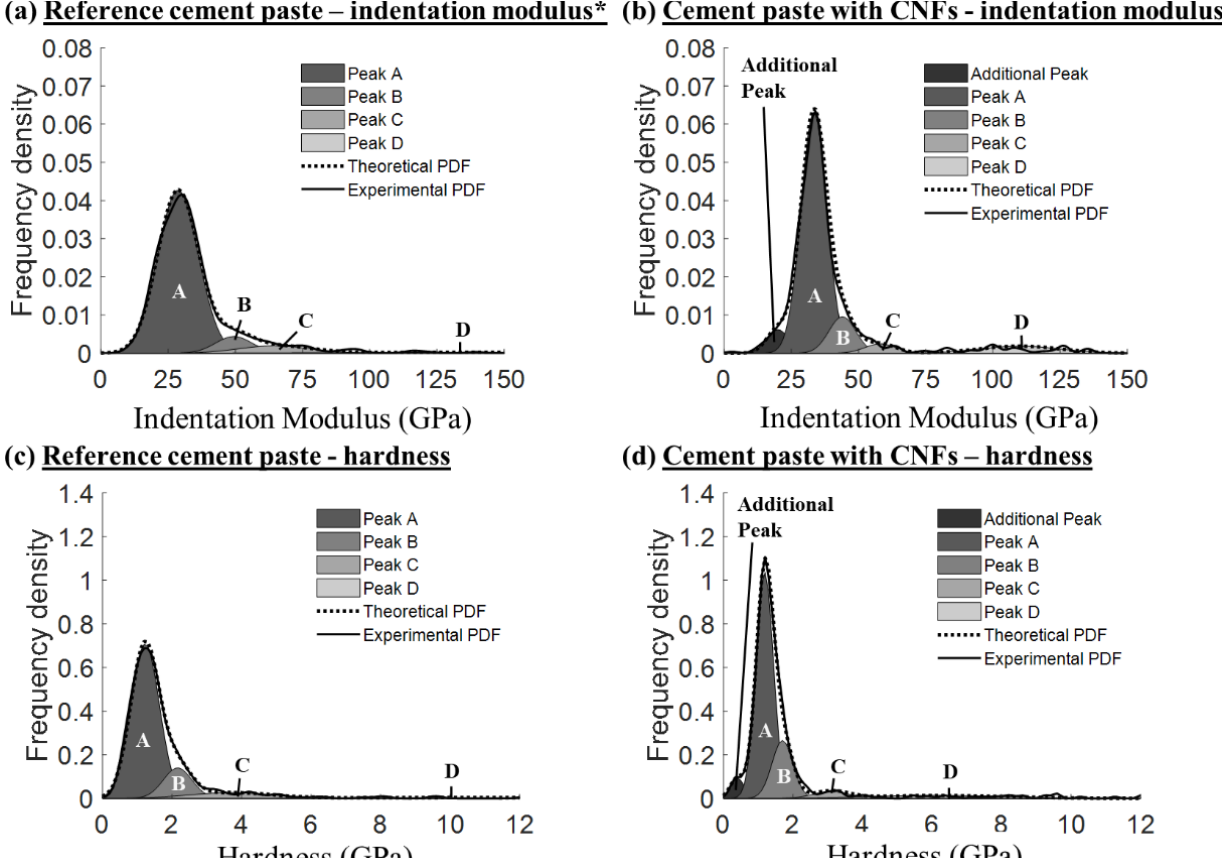
Figure 3. Histograms of the indentation ( a ) modulus and ( b ) hardness for the reference cement paste (414 valid indents) and the cement paste with CNFs (479 valid indents).